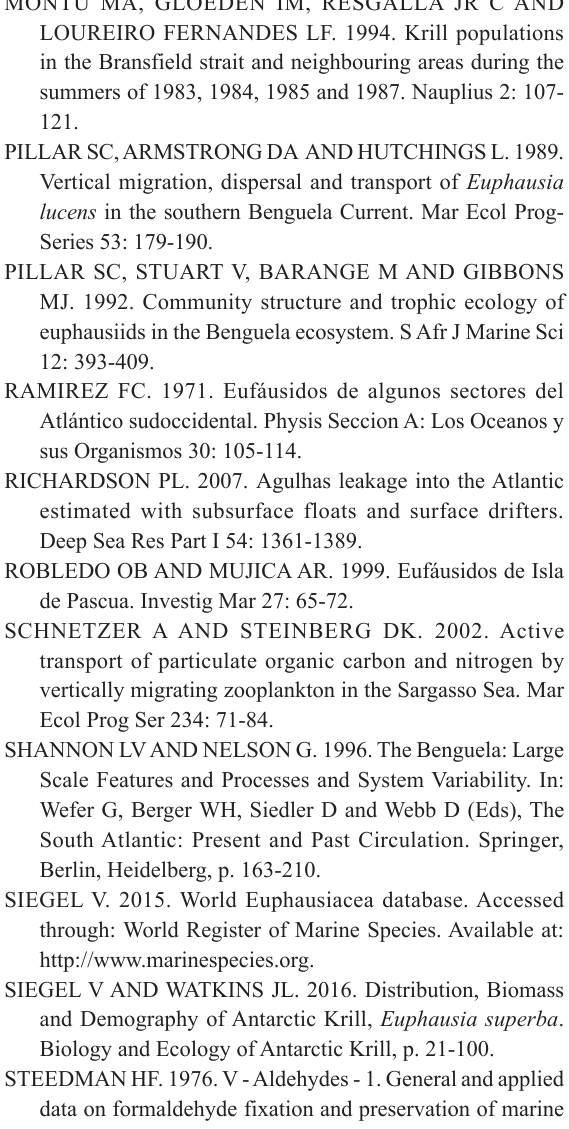
Table SI - Zooplankton data for the South Atlantic Ocean during the First Transatlantic Commission (Brazil-Africa) in 2009, showing the stations, sampling dates, sampling time, coordinates, local ocean depth and sampling depth. Table SII - SIMPER test to identify the contribution index (CI) of euphausiid species between sampling stations toward the western (Brazil) and eastern (Africa) sides of the South Atlantic Ocean. Table SIII - Main literature about euphausiid distribution in South Atlantic waters. Figure S1 - Sea surface temperature and temperature vertical profile along the 30 °S transect through the South Atlantic Ocean. Figure S2 - Adult males of ( a ) Thysanopoda astylata and ( b ) T. aequalis . Details show ( c ) the dactylus of the third thoracic leg of T. astylata, and ( d ) the long flagellum spine modification of the dactylus of the third thoracic leg of T. aequalis